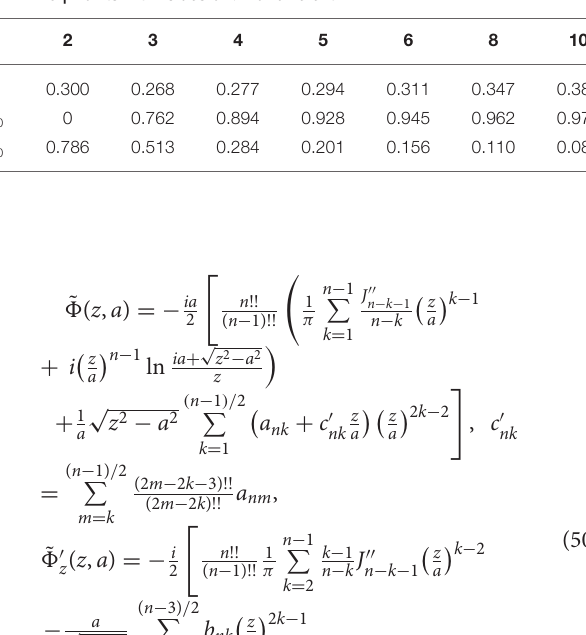
TABLE 3 | Points with values of τ * for different n